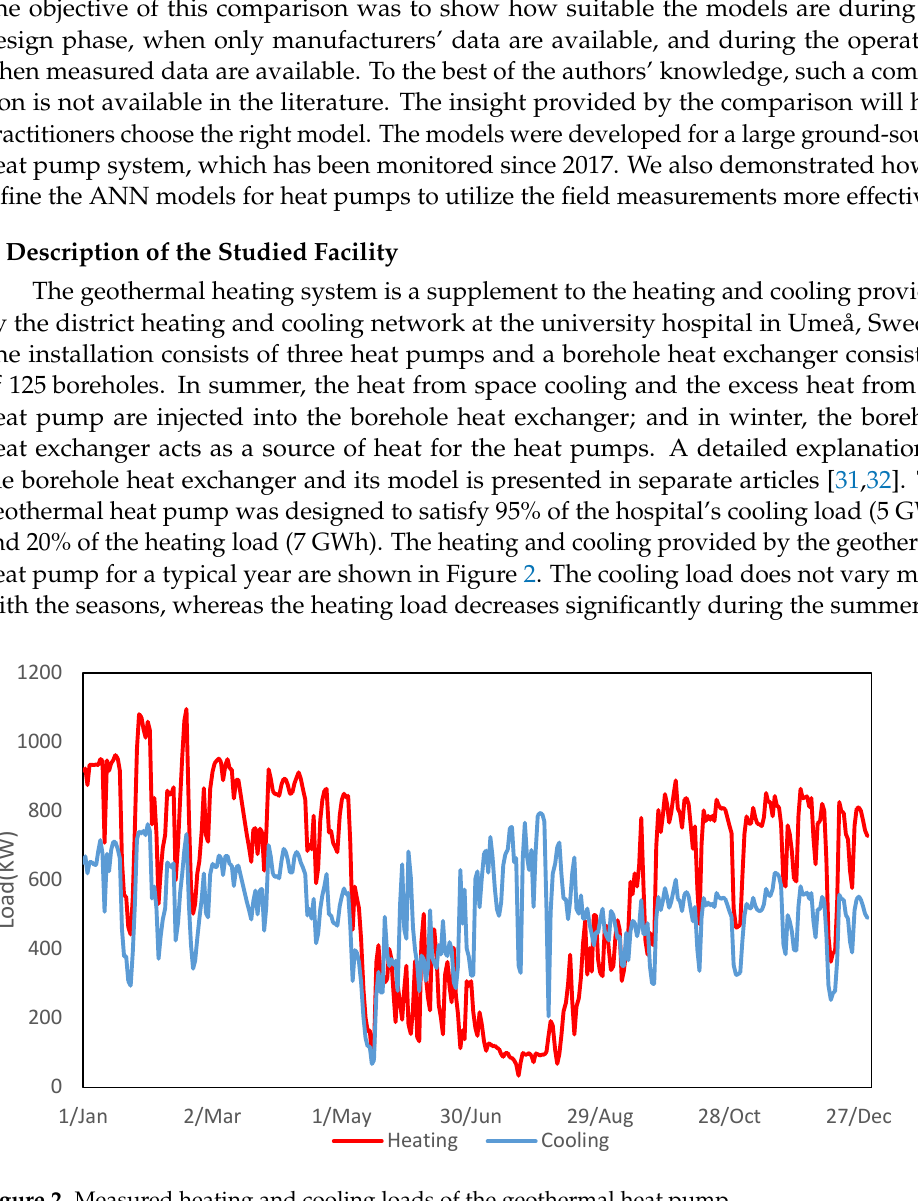
Figure 2. Measured heating and cooling loads of the geothermal heat